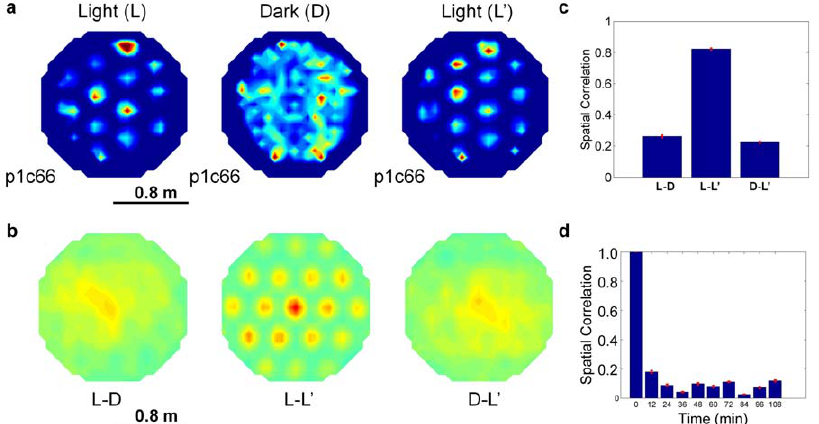
Figure 6. Firing fields drift in darkness and re-stabilize in the illuminated environment. (a) Firing fields in each experiment phase. (b) Cross-correlation plots of firing fields in light and darkness. (c) Spatial correlation of firing fields in light and dark periods. (d) Spatial correlation over time during darkness. Note the initial rapid decline in correlation. (all data, means 6 s.e.m. See Text S1 for further details.)